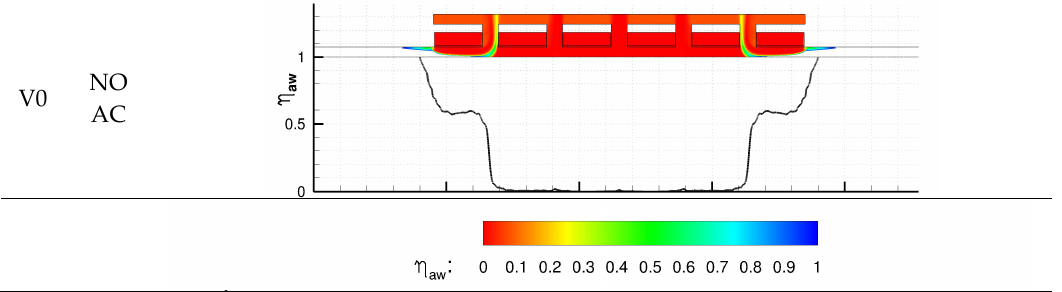
Figure 16 . Adiabatic wall effectiveness coefficient distribution for the reference configuration without air curtains and the best configuration with warm air curtains, at 20 m/min fabric